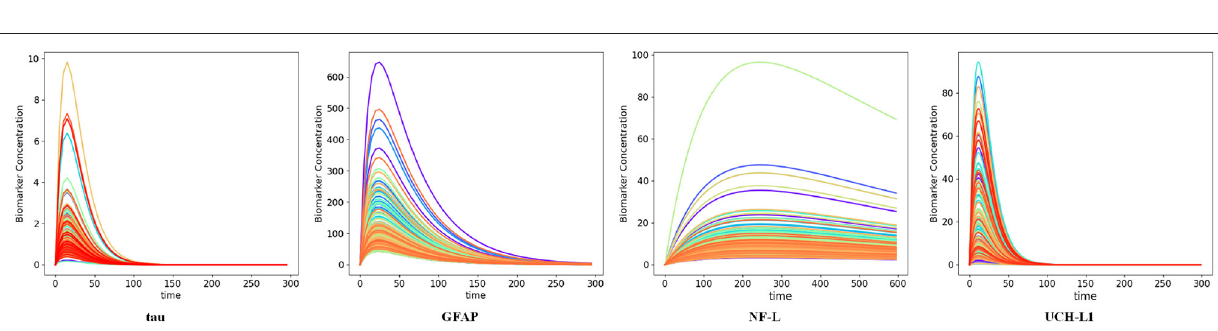
FIGURE 10 | Time-concentration curves for concussed subjects with available biomarker data as estimated by the kinetic models. Each curve represents one subject in the data. Note resemblance of displayed curves to nominal time-concentration curves shown in Figure 3